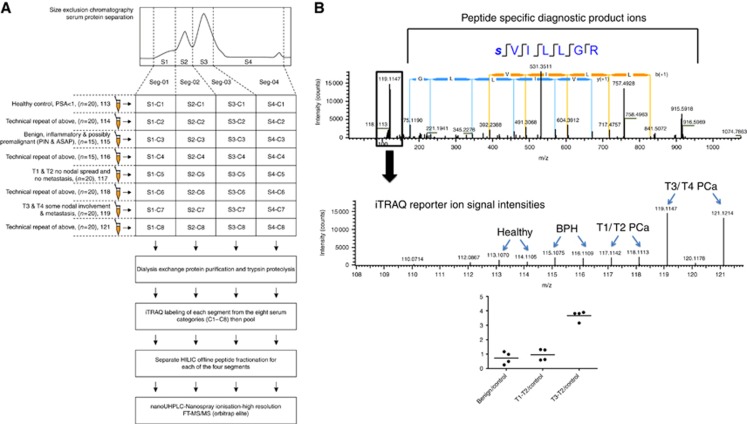
Mass Spectrometry Methodology. (A) Illustration of the multiplex quantitative serum proteomics method used for the discovery findings. TR=technical repeat, iTRAQ labels are in bold. The method utilises multidimensional liquid chromatography, stable isotope labelling of surrogate tryptic peptides and ultra-high resolution/precision tandem mass spectrometry using the state-of-the-art FT-Obritrap Elite platform. (B) Annotated high-resolution (FTMS) product ion mass spectrum of the tryptic peptide SVILLGR, uniquely traceable to PSA with an expanded view of the low-mass region (and a dot plot) showing the observed iTRAQ reporter ion intensities, demonstrating the highest abundance of the PSA proteotypic peptide occurring for the T3–T4 PCa clinical cohorts.